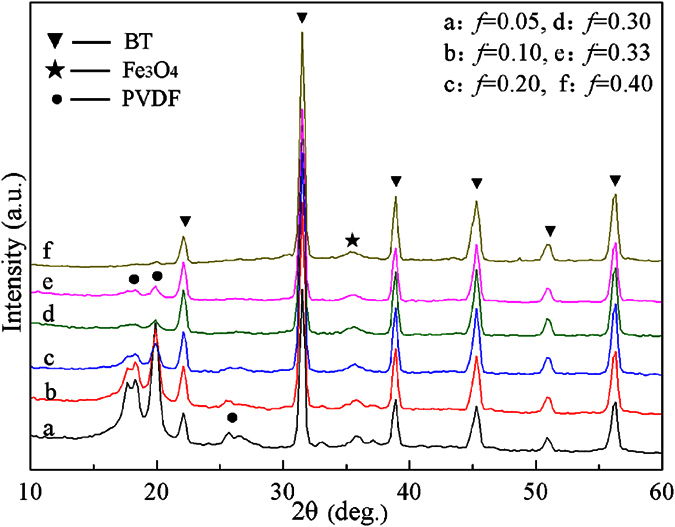
XRD patterns from the BT–0.3Fe3O4/PVDF composites with BT–0.3Fe3O4 volume fractions between 5 vol.% and 40 vol.%.